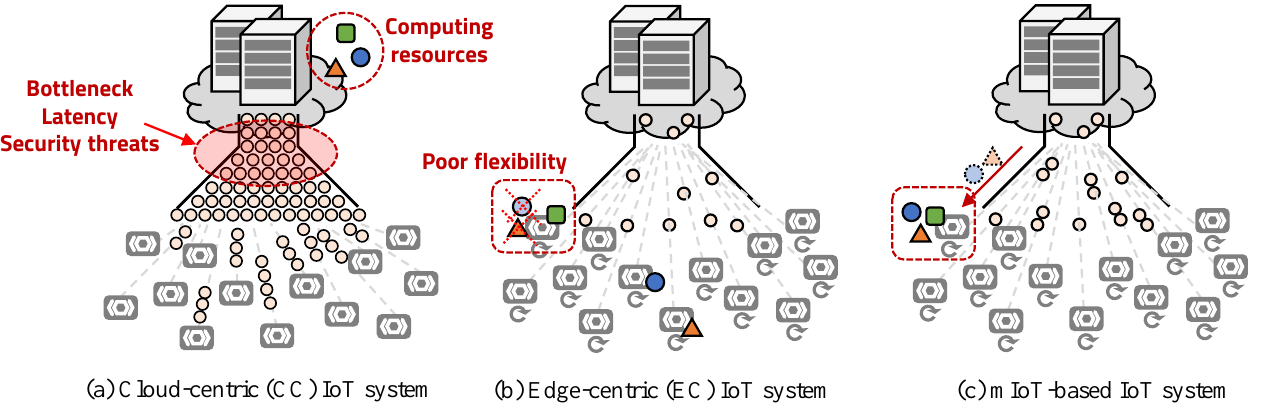
Figure 3. Comparison between CC, EC, and mIoT-based IoT